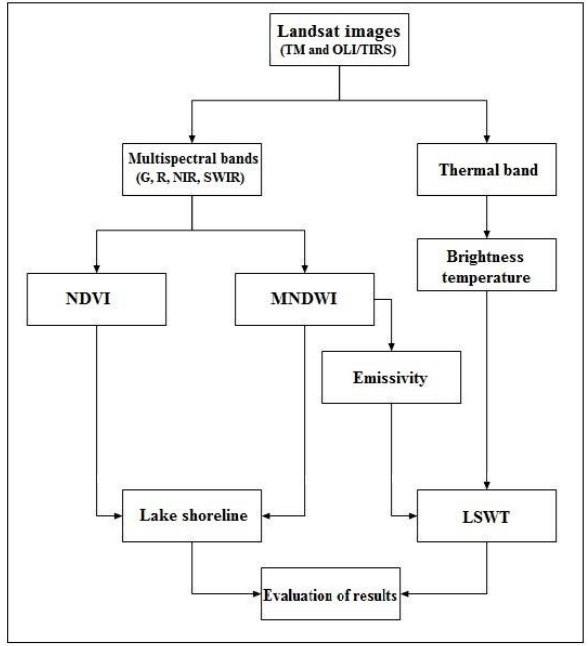
Figure 2 . The flowchart of the